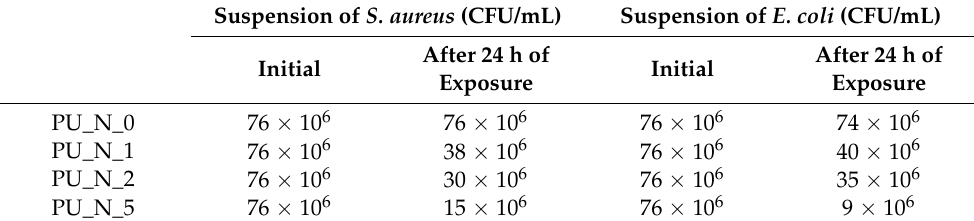
Figure 7. The cellular structure of ( a ) PU_N_0, ( b ) PU_N_1, ( c ) PU_N_2 and ( d ) PU_N_5 observed at a magnification of ×150. Adapted from Ref. [10]. Table 5. Microbial properties of PU composite foams against Staphylococcus aureus and Escherichia coli. [10].